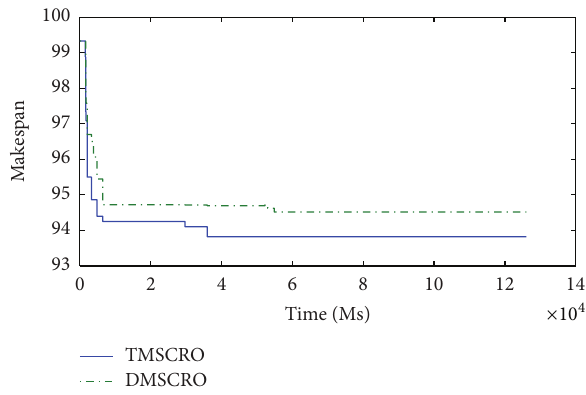
Figure 26: The convergence trace for the randomly generated DAGs with each containing 20